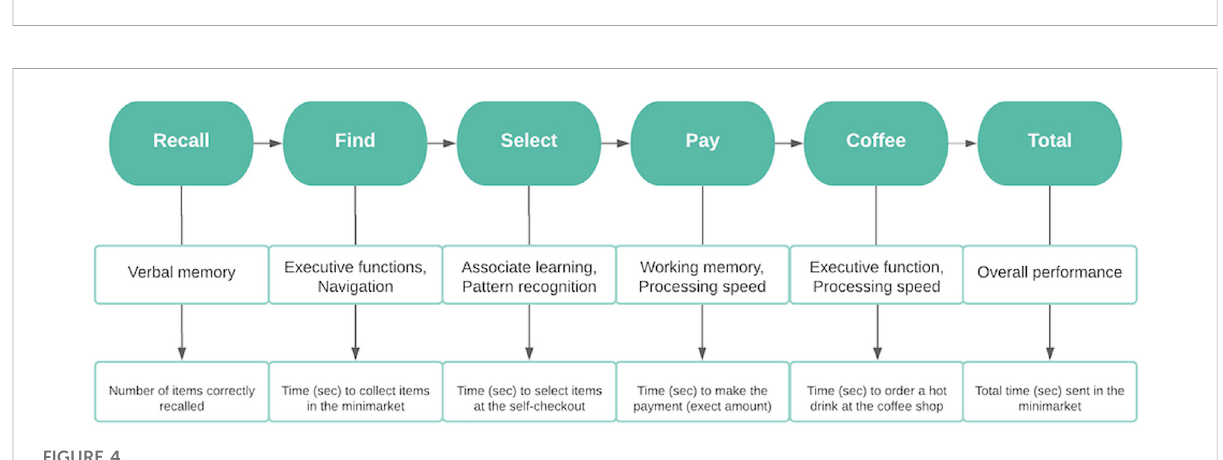
FIGURE 3 VStore self-checkout machine. © Porffy et al. (2022). Originally published in the Journal of Medical Internet Research (https://www.jmir.org), 26.01.2022. This is an open-access article distributed under the terms of the Creative Commons Attribution License (CC BY 4.0). No changes were made in the reproduction of this article.